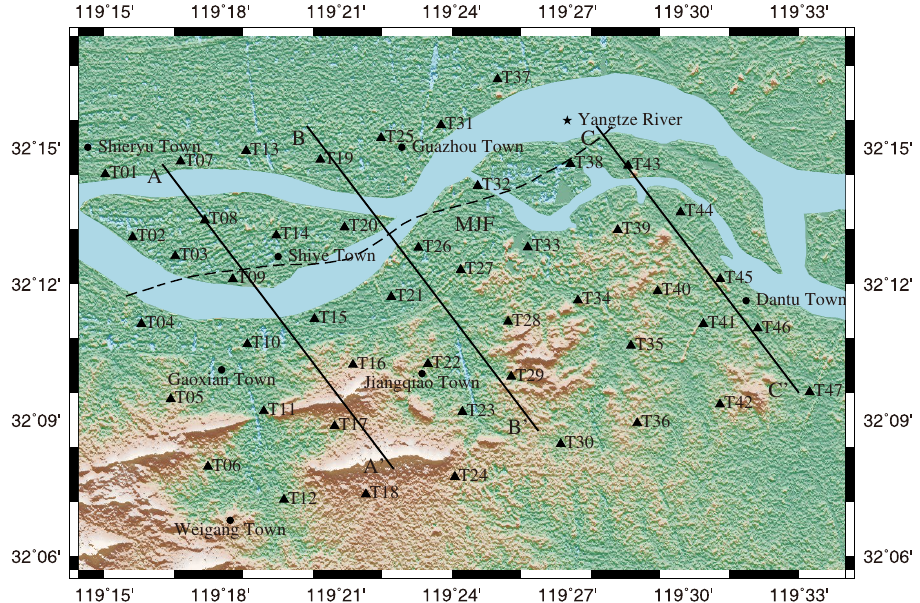
Figure 2. Distribution of seismic array stations (black triangles) in Zhenjiang area. The black lines marked by AA’, BB’ and CC’ represent the profiles shown in Figs. 9 and 10. The dotted black line represents MJF. (The software used to create the map is GMT V5.4.5, https ://www.gener ic-mappi ng-tools